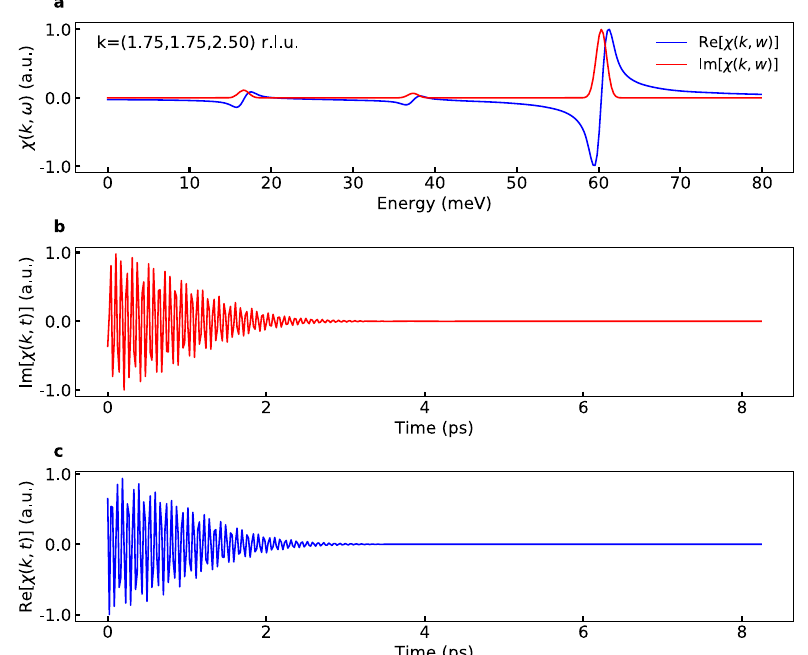
Fig. 3 Decay width and dynamics of phonon modes excited by an extended source in x . a Real and imaginary parts of χ ( k , ω ). b Imaginary and c real parts of χ ( k , t ). Here, the phonon modes at a speci fi c k value of k 0 = (1.75, 1.75, 2.50) r.l.u. are excited by an extended source in x . All the quantities plotted in sub-plots are